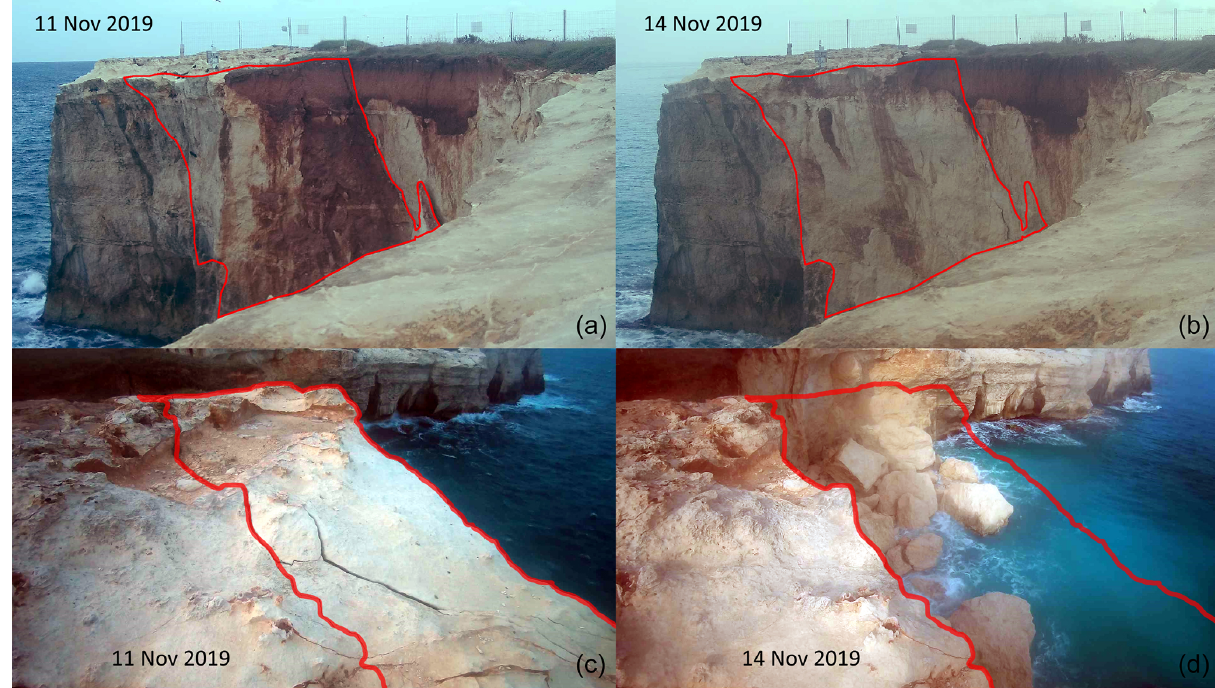
Figure 2. The first rockfall (marked with “A” in Fig. 1) – panel (a) shows the cliff as it was on 11 November 2019 and panel (b) shows it as it was 3d later (both images are taken from the Raspberry Camera Module – see Fig. 1 for the position). Panels (c) and (d) show the same event but from a different point of view (the secondary camera – see Fig. 1 for the position): (c) a picture taken before the collapse and (d) a picture taken on 14 November